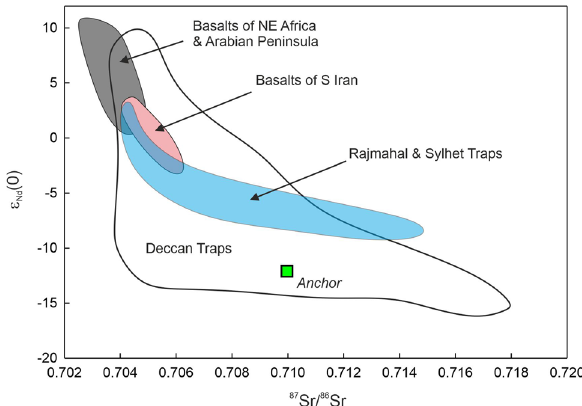
Figure 6. ε Nd (0) versus 87 Sr/ 86 Sr of the Chilika Anchor rockcompared with the same for the Deccan Traps (Basu et al., 2020) 17 , basalts of north-eastern Africa and Arabian peninsula (Ethiopia, Kenya, Saudi Arabia and Yemen; Kieffer et al., 2004 18 and references therein), basalts of southern Iran (Yeganehfar et al., 2013) 19 , and basaltic flows of Rajmahal and Sylhet Traps 20 .